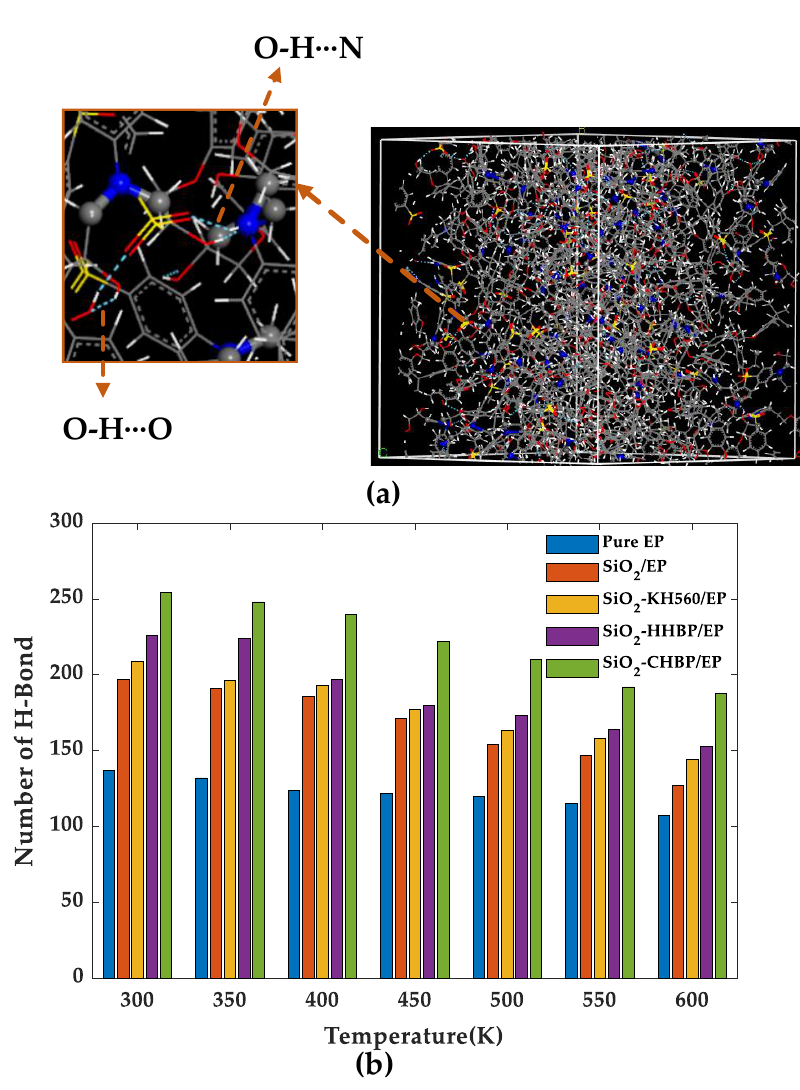
Figure 9. ( a ) Schematic diagram of different kinds of hydrogen bonds; ( b ) number of hydrogen bonds of five models.